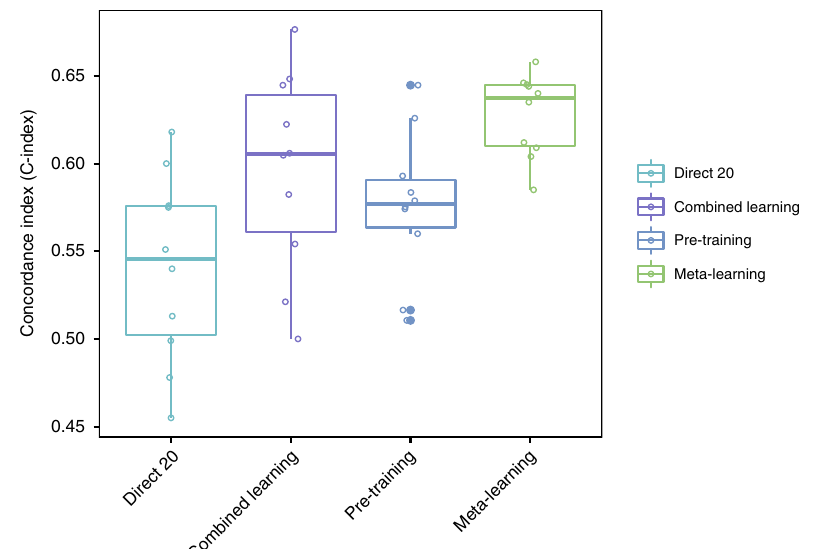
Fig. 7 C-Index for survival prediction on the independent lung cancer cohort, comparing small (20) size sample direct learning, combined learning, regular pre-training, and meta-learning. n = 64 testing samples from lung cancer cohort over 10 independent experiments. The upper and lower bars in the box-plots represent the largest and smallest data points excluding any outliers. The upper and lower bounds of the boxes represent the 25th percentile and 75th percentile of the data, respectively. The middle bars represent the median of the